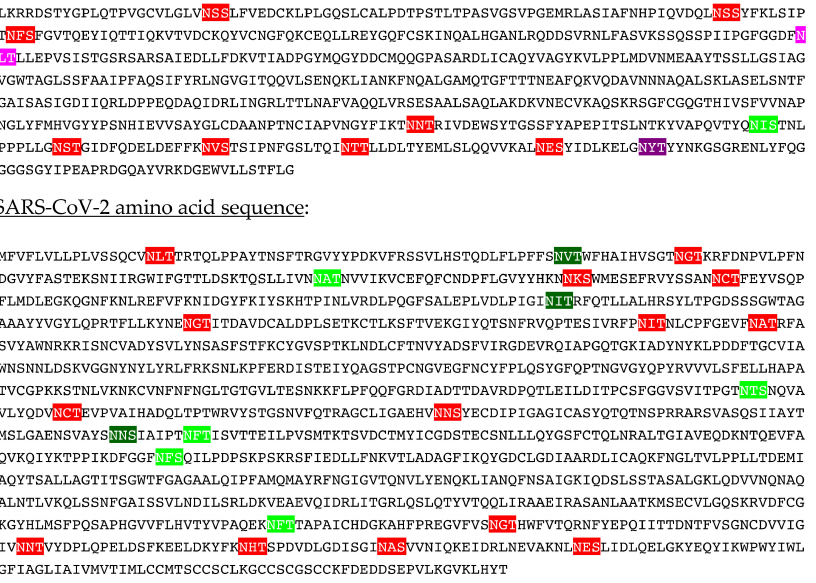
Figure 24. Amino acid sequences of S proteins from SARS-CoV, MERS-CoV, and SARS-CoV-2, showing the N -glycosylation sites occupied (almost) exclusively by complex type N -glycans (red), high-mannose type N -glycans (green), hybrid type N -glycans (purple), and predominantly occupied by high-mannose glycans (pale green) or complex glycans